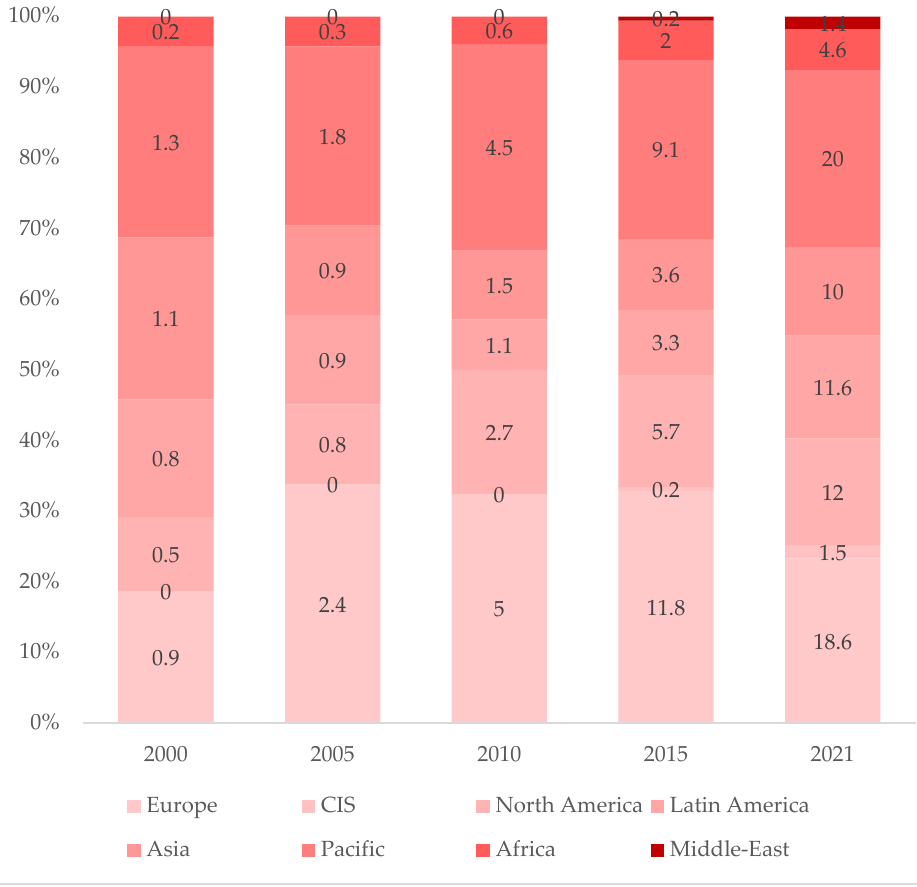
Figure 2. Share of wind and solar energy in electricity generation by region, 2000; 2005; 2010; 2015; 2021, % [10].